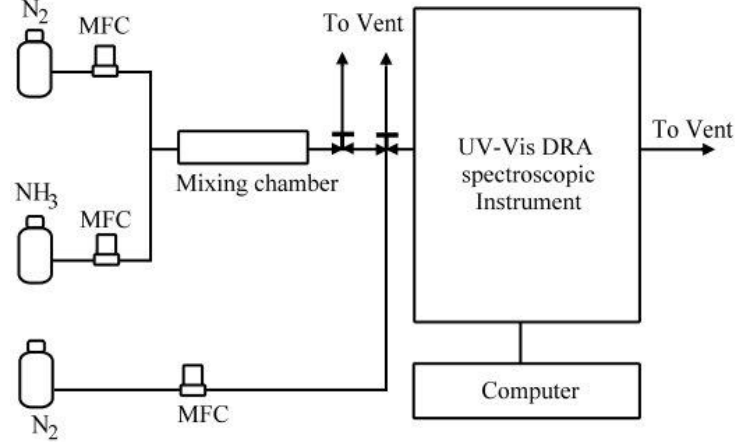
Figure 1. Schematic diagram of a UV-Vis DRA spectroscopic instrument for NH